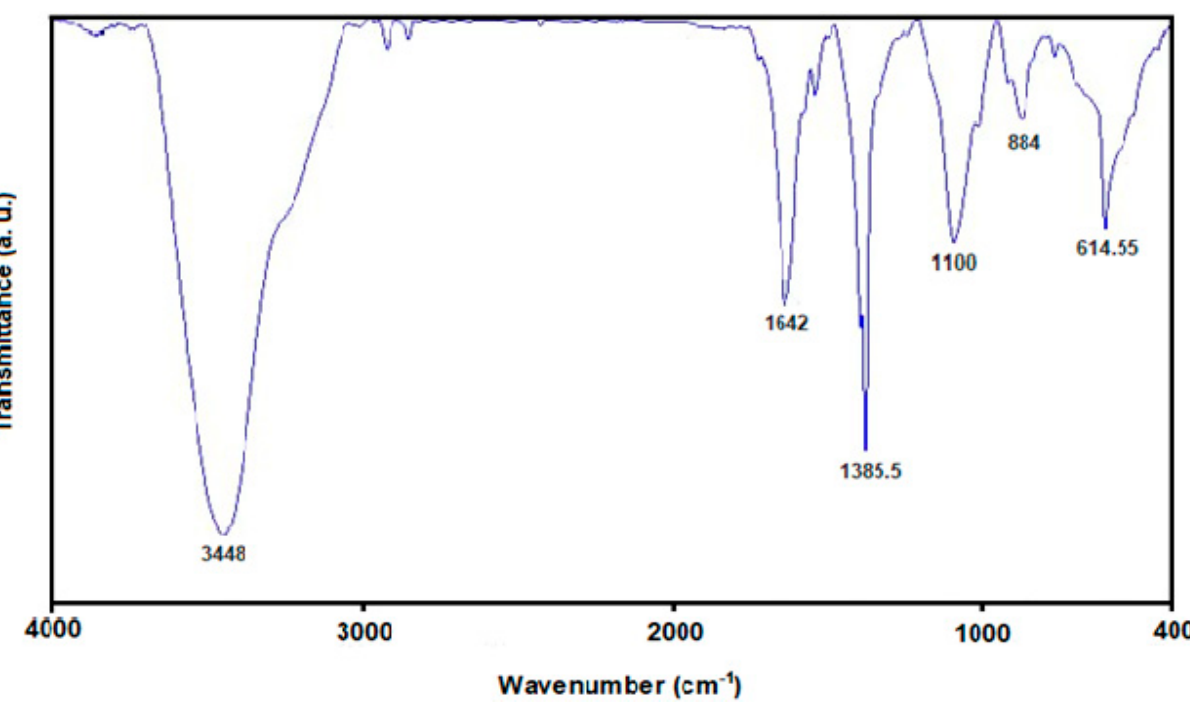
Figure 2. The XRD pattern captured for MoS 2 NSs.